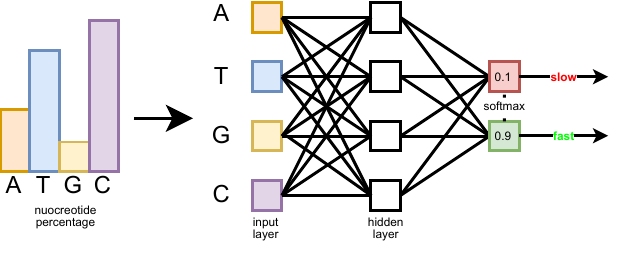
Figure 5. The MLP architecture having the nucleotide frequencies as input, and predicting the sequence class probability distribution (slow or fast).